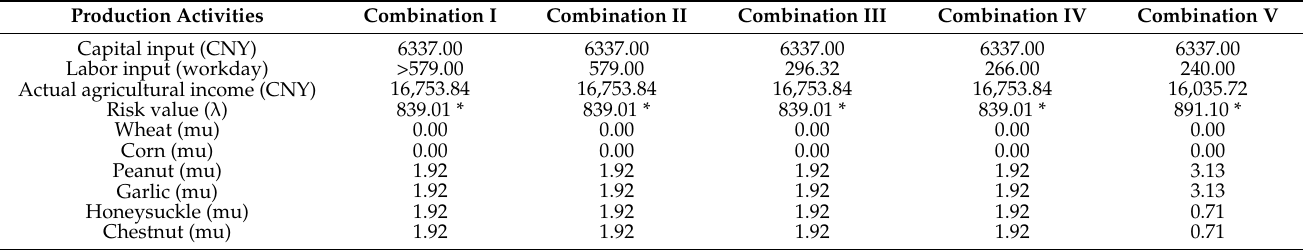
Table 7. Optimization of labor input for FTPH